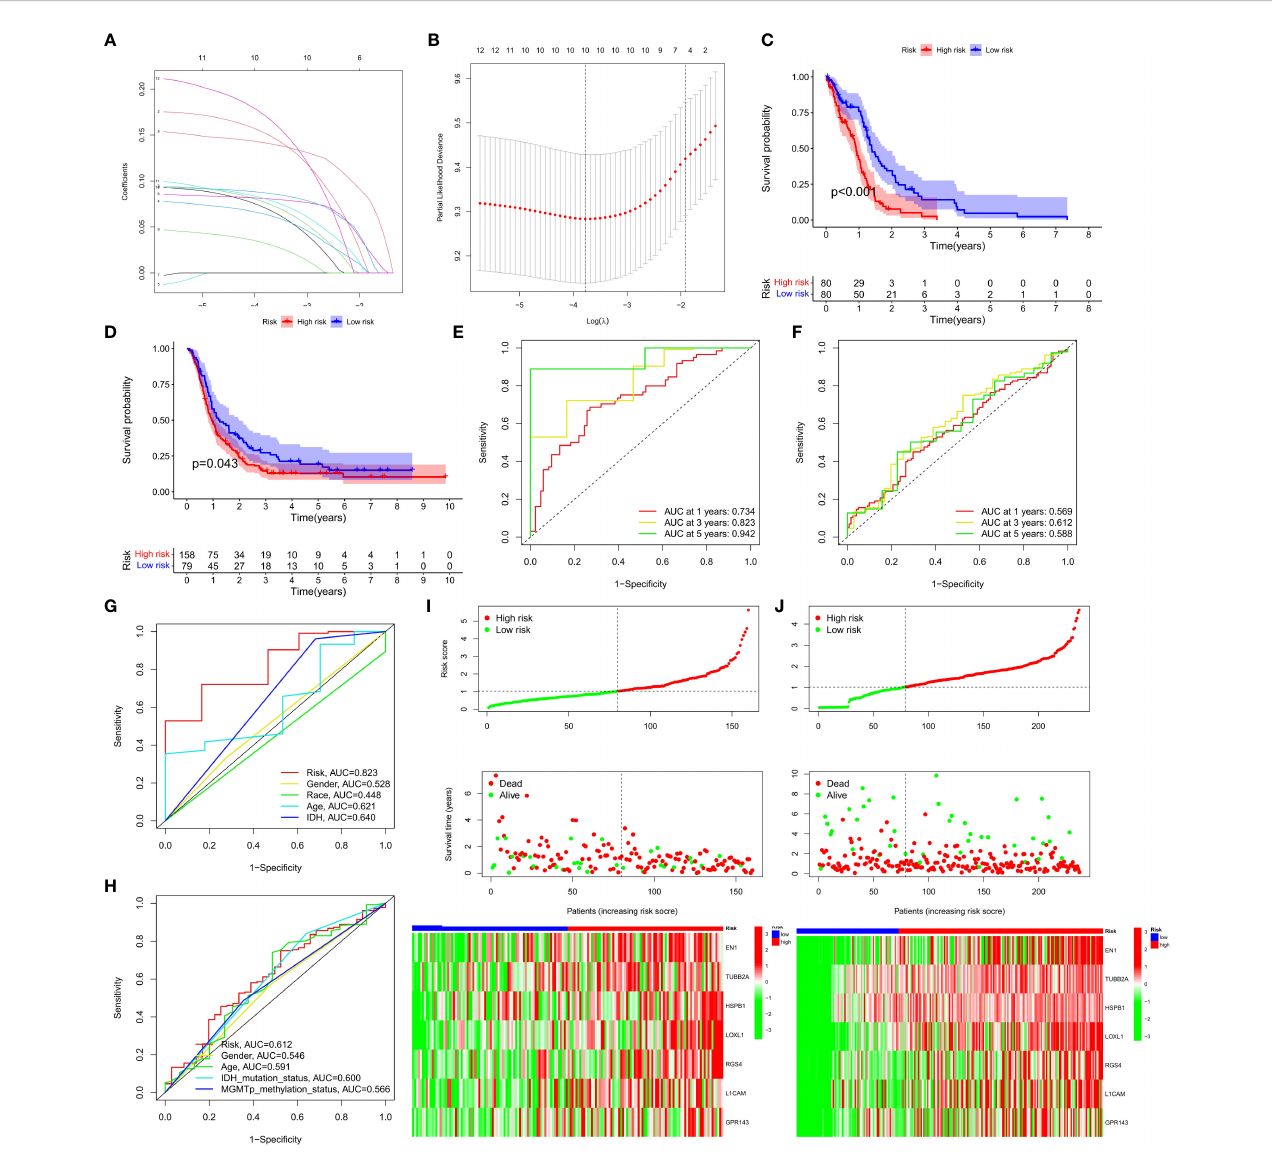
FIGURE 7 Development and validation of prognostic models for GBM patients. (A) The 10-fold cross-validation LASSO analysis found seven prognostic genes. Each curve represents one gene. (B) Plots illustrating the coef fi cient pro fi les for seven prognostic NRGs. The best lambda is where vertical dashed lines are drawn. (C, D) Survival curves showing the risk strati fi cation ability of TCGA and CGGA cohorts. (E, F) AUC values for TCGA and CGGA cohort risk groupings at 1, 3, and 5 years. (G, H) AUC values for 3-year clinical characteristics and risk groups for the TCGA and CGGA cohorts. (I, J) The risk plots of survival status of each sample in the TCGA and CGGA cohorts. Heat map showing the expression of each gene ’